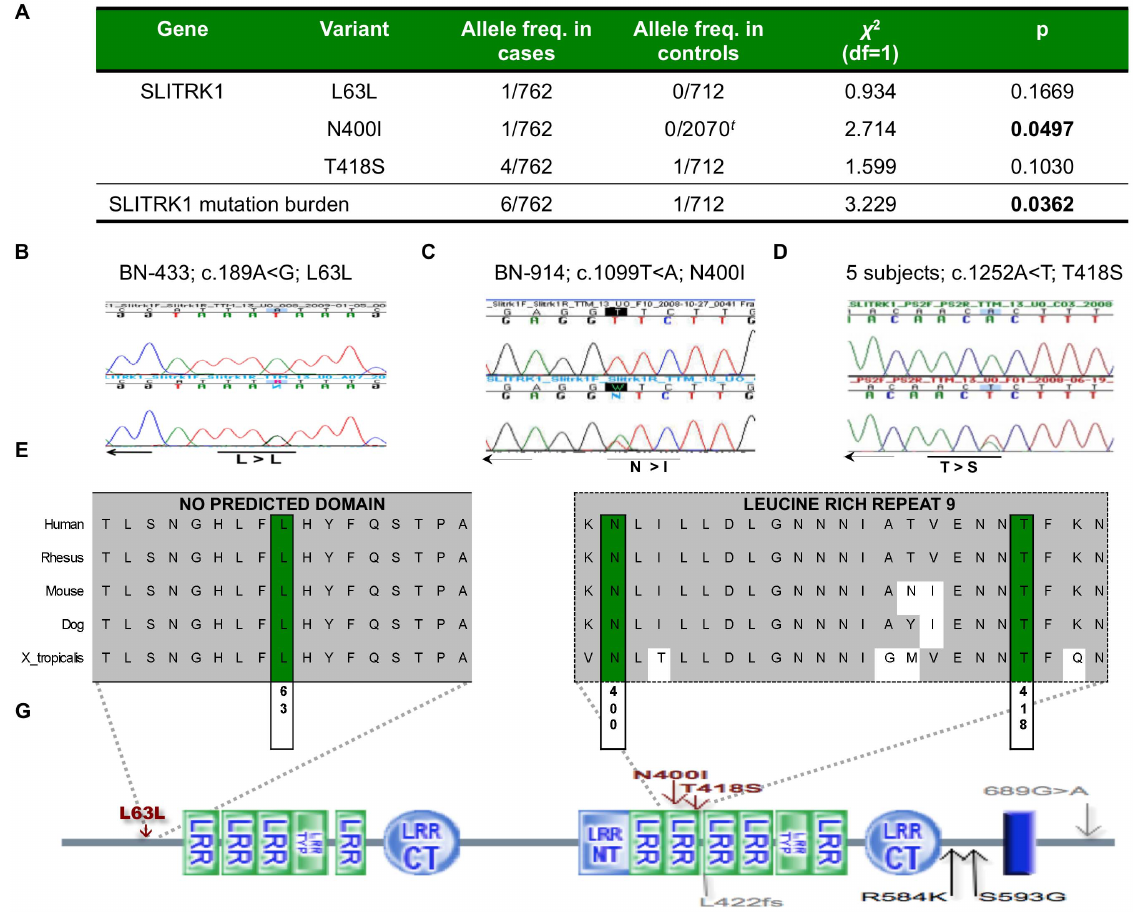
Figure 1. Novel mutations identified in SLITRK1 . ( a ) Allelic frequency of novel SLITRK1 mutations identified in obsessive-compulsive disorder (OCD) cases. ( b ) The SLITRK1 L63L mutation has been demonstrated by sequencing in one of 762 OC spectrum alleles and in zero of 712 control alleles. ( c ) The SLITRK1 N400I mutation has been demonstrated via sequencing and genotyping in one of 646 OC spectrum alleles and in zero of 2070 control alleles, respectively; t includes genotyping of 1358 alleles. ( d ) The SLITRK1 T418S mutation has been demonstrated by sequencing in three of 762 OC spectrum alleles and in one of 410 control alleles. ( d ) Conservation map of SLITRK1 region where the three novel mutations were identified (Green – novel variants, gray – evolutionarily conserved regions). ( e ) A schematic of the SLITRK1 protein with the detected variants identified (red – novel variants, gray – previously published variants in Tourette syndrome 4 , black – published variants in trichotillomania 5 . Dotted outline depicts leucine rich repeat (LRR) region 9. Diagram of SLITRK1 is available at http://smart.embl-heidelberg.de. LRR typ – LRR typical subfamily, LRR CT – LRR C- terminal domain, LRR N-terminal domain; dark blue bar – transmembrane domain.